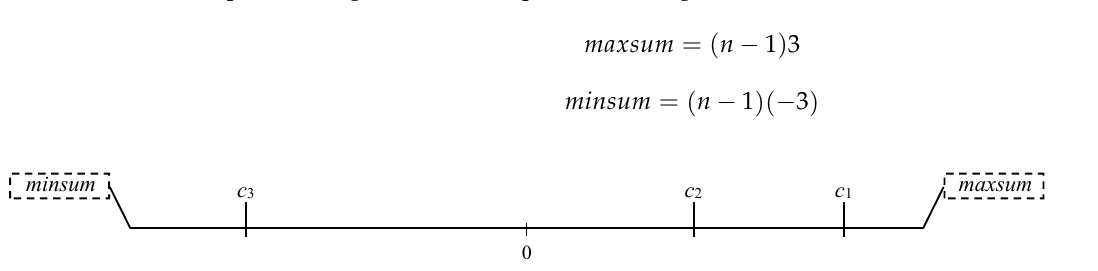
Figure 3. Performance of criteria into the scale considering the maximum sum and minimum sum .